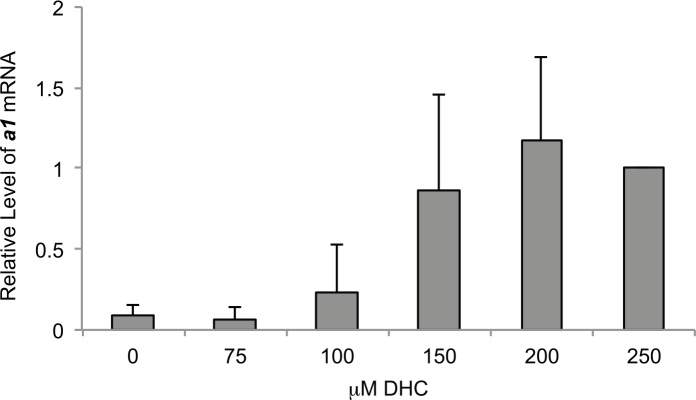
DHC inhibits silencing of a1 at HMR.Transcript levels of a1 relative to SCR1, an internal control, were measured by qRT-PCR in logarithmically growing cells in the presence or absence of DHC. The levels of transcripts present in samples treated with 250 μM DHC was set to 1. Data was calculated as: 2[(a1CT − SCR1CT)DHC − (a1CT − SCR1CT)No DHC] (AVG ± SD, n = 5).